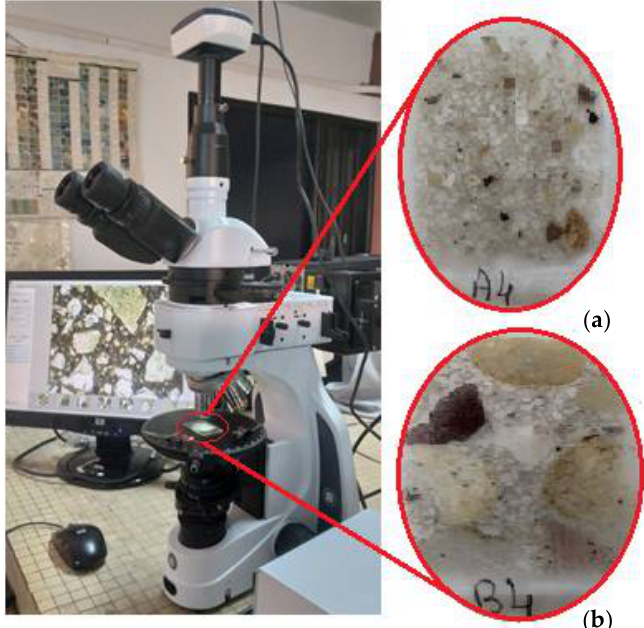
Figure 4. Euromex iscope optical microscopic of thin blade samples: ( a ) after ASR test of MRWG50 and ( b ) at 90 days of cured CRWG50.